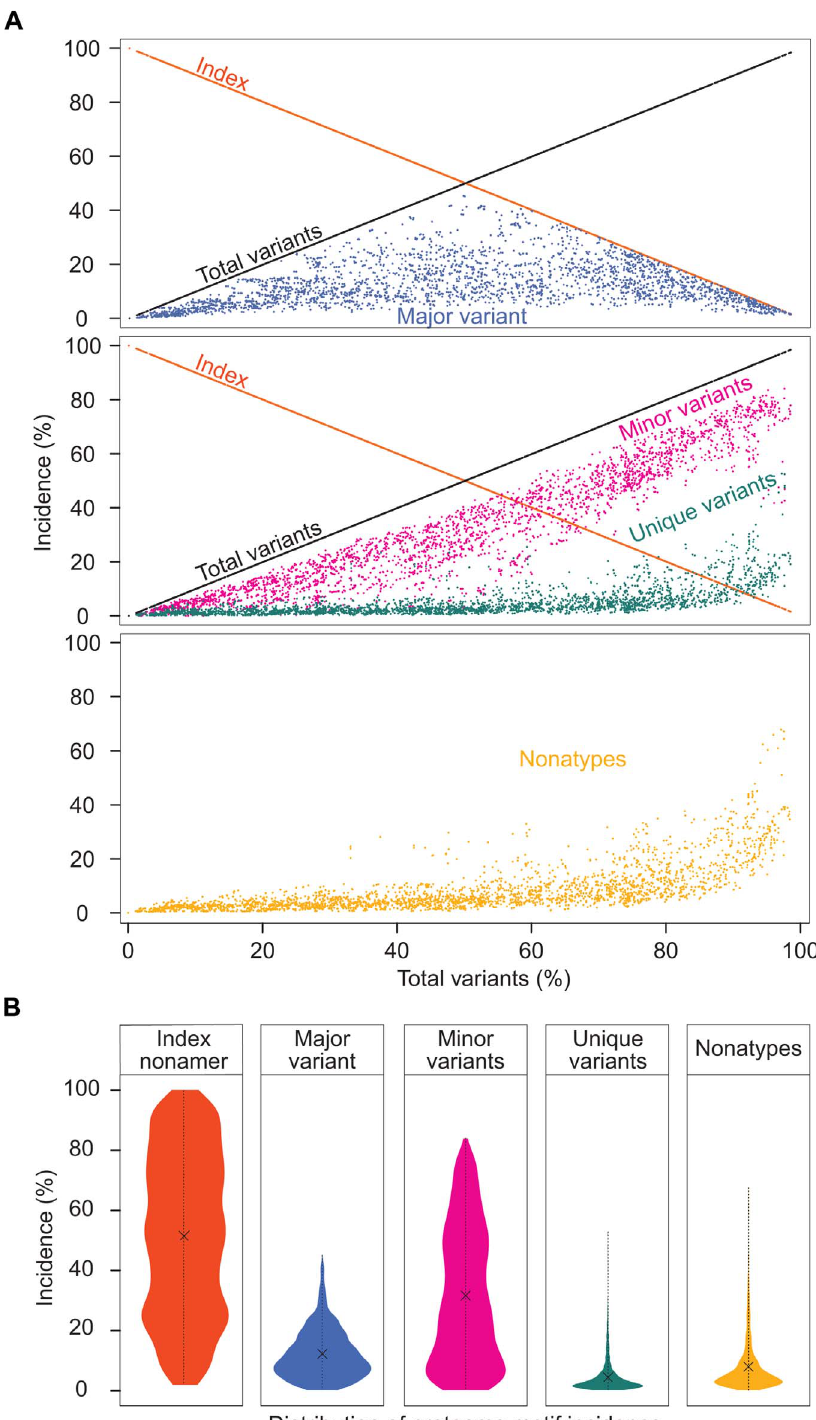
Figure 4. Dynamics of diversity motifs of HIV-1 clade B proteome. A. Motif incidence in relation to total variants incidence: index sequence (orange), total variants (black), major variant (blue), minor variants (pink), unique variants (green), and nonatypes (yellow). B. Violin plot of the frequency distribution of the indicated proteome sequence motifs. The width of the plot (x-axis) represents the frequency distribution of a given incidence of the indicated motif. ‘‘ x ’’ represents the arithmetic mean incidence value.